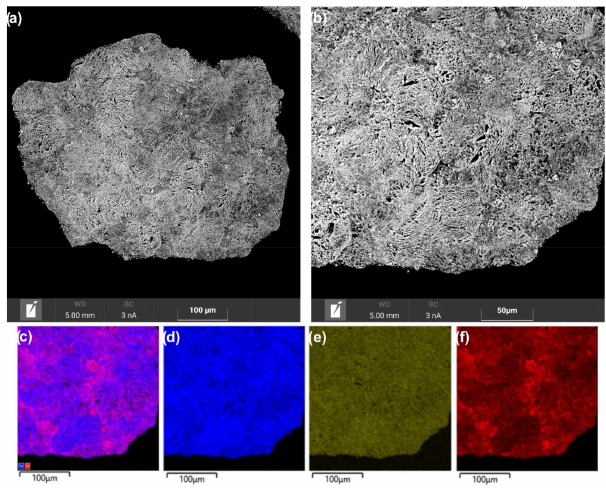
Figure 7. SEM images ( a , b ) and EDX mapping patterns ( c – f ) for nickel (red), zirconium (green), and cerium (blue) of cross-section area of the Ni/Ce 0.9 Zr 0.1 O 2 catalyst. The catalytic performance of the Ni/Ce 1 − x Zr x O 2 catalysts in CO 2 methanation was studied. Figure 8 shows light-off curves for the CO 2 methanation. For all the catalysts, the CH 4 concentration increases with temperature, reaches a maximum, and then decreases coinciding with the equilibrium values. All the Ni/Ce 1 − x Zr x O 2 catalysts had comparable or higher activity in comparison with the industrial 38Ni-Cr-Al catalyst containing a significantly higher amount of nickel (38 wt.% vs. 10 wt.%). In a previous work, we reported that the synergism of redox properties of the Ni/Ce 1 − x Zr x O 2 system enhances the catalytic performance in the methanation of carbon oxides [26].